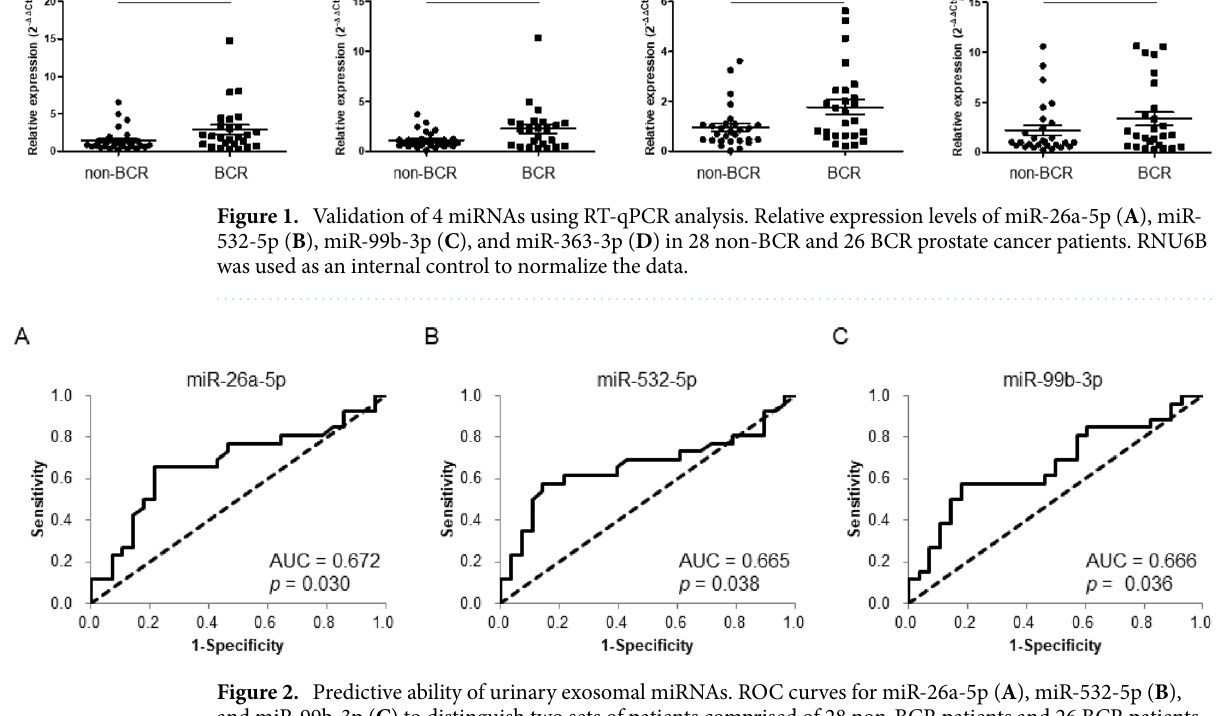
Figure 2. Predictive ability of urinary exosomal miRNAs. ROC curves for miR-26a-5p ( A ), miR-532-5p ( B ), and miR-99b-3p ( C ) to distinguish two sets of patients comprised of 28 non-BCR patients and 26 BCR